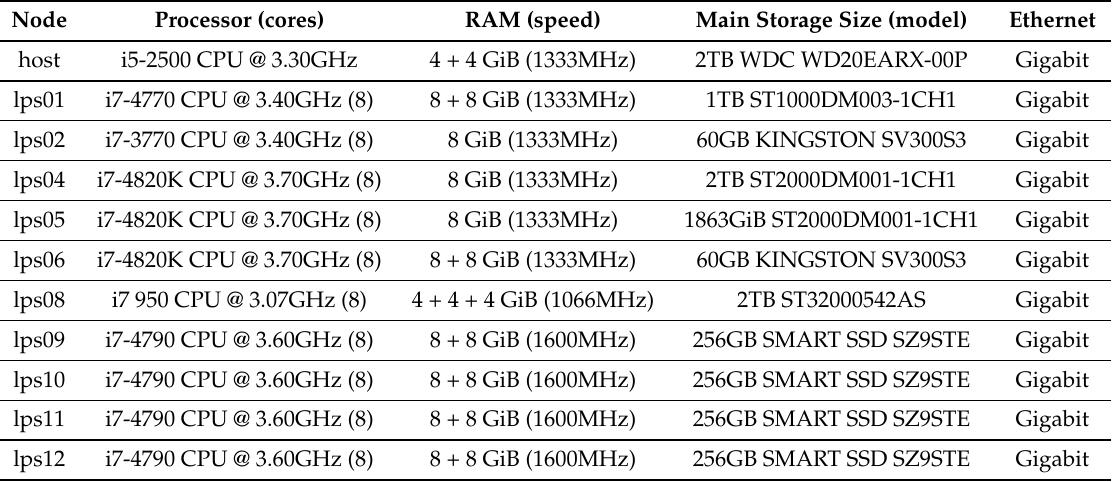
Table A2. Cluster hardware configuration. RAM modules were listed separately since some nodes have multiple memory modules to explore dual channels. Main storage describes storage media used during script execution, and some nodes might have other unused storage media.